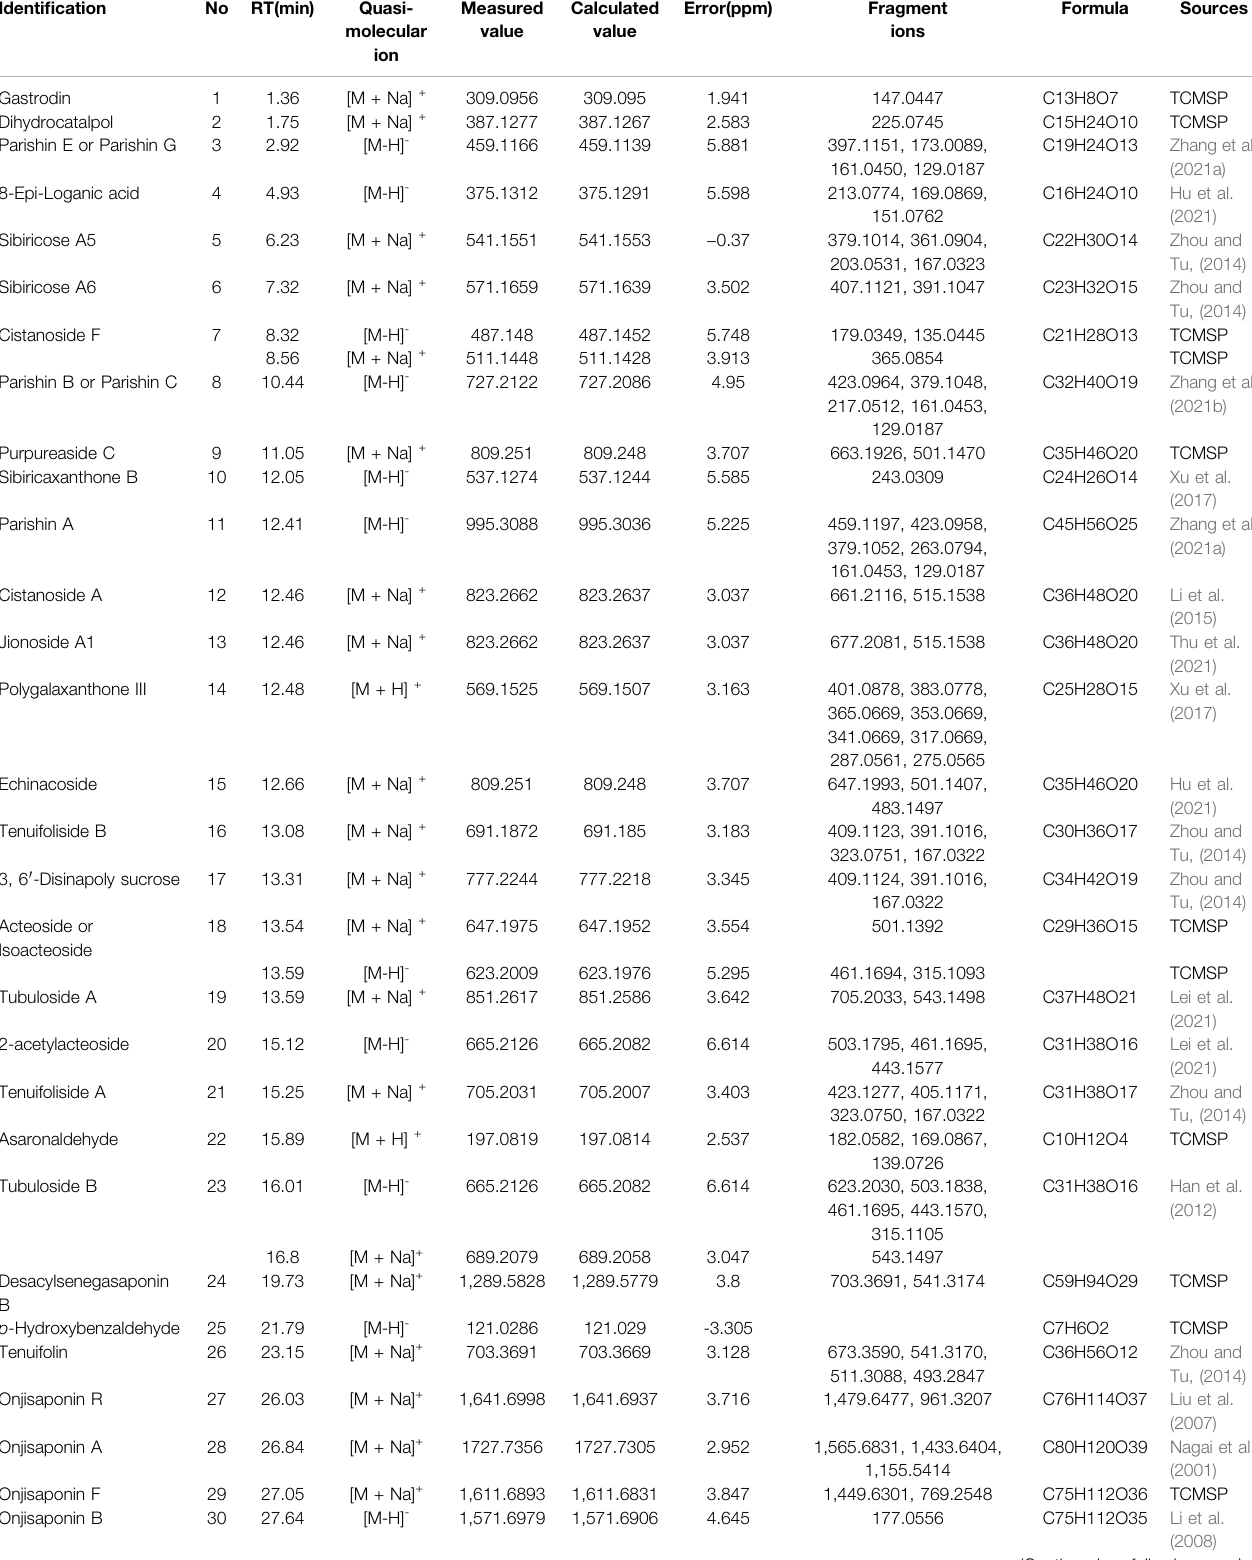
TABLE 1 | | Analysis of the chemical constituents of GPCRAC extracts by UHPLC-Q-Orbitrap in positive and negative ion